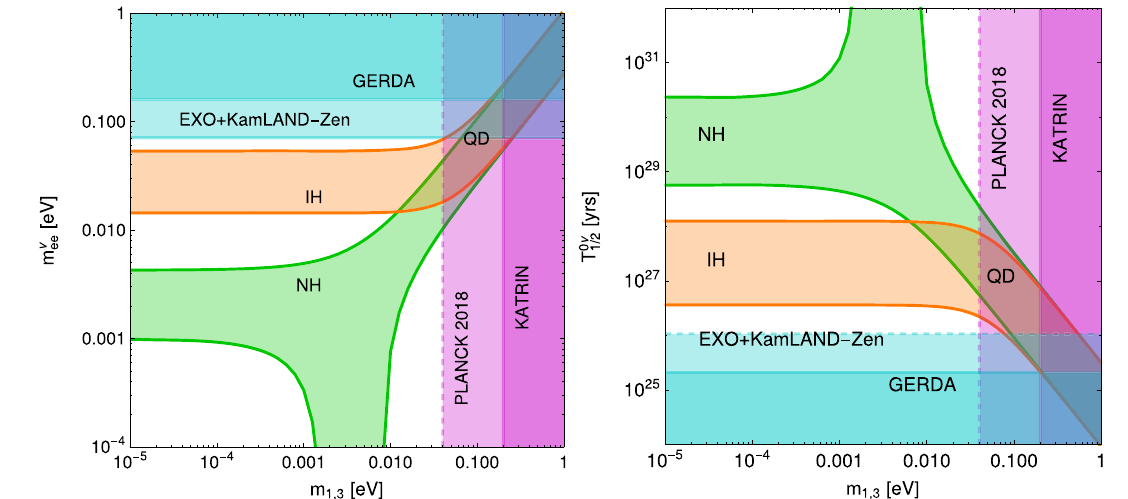
Fig. 7 Left panel: Effective Majorana mass parameter ( | m ee | ) due to standard mechanism as a function of lightest neutrino mass m 1 ( m 3 ) for NH (IH). Right panel: SM contribution to the half-life of 0 νββ transi- tion as a function of lightest neutrino mass. The blue horizontal bands